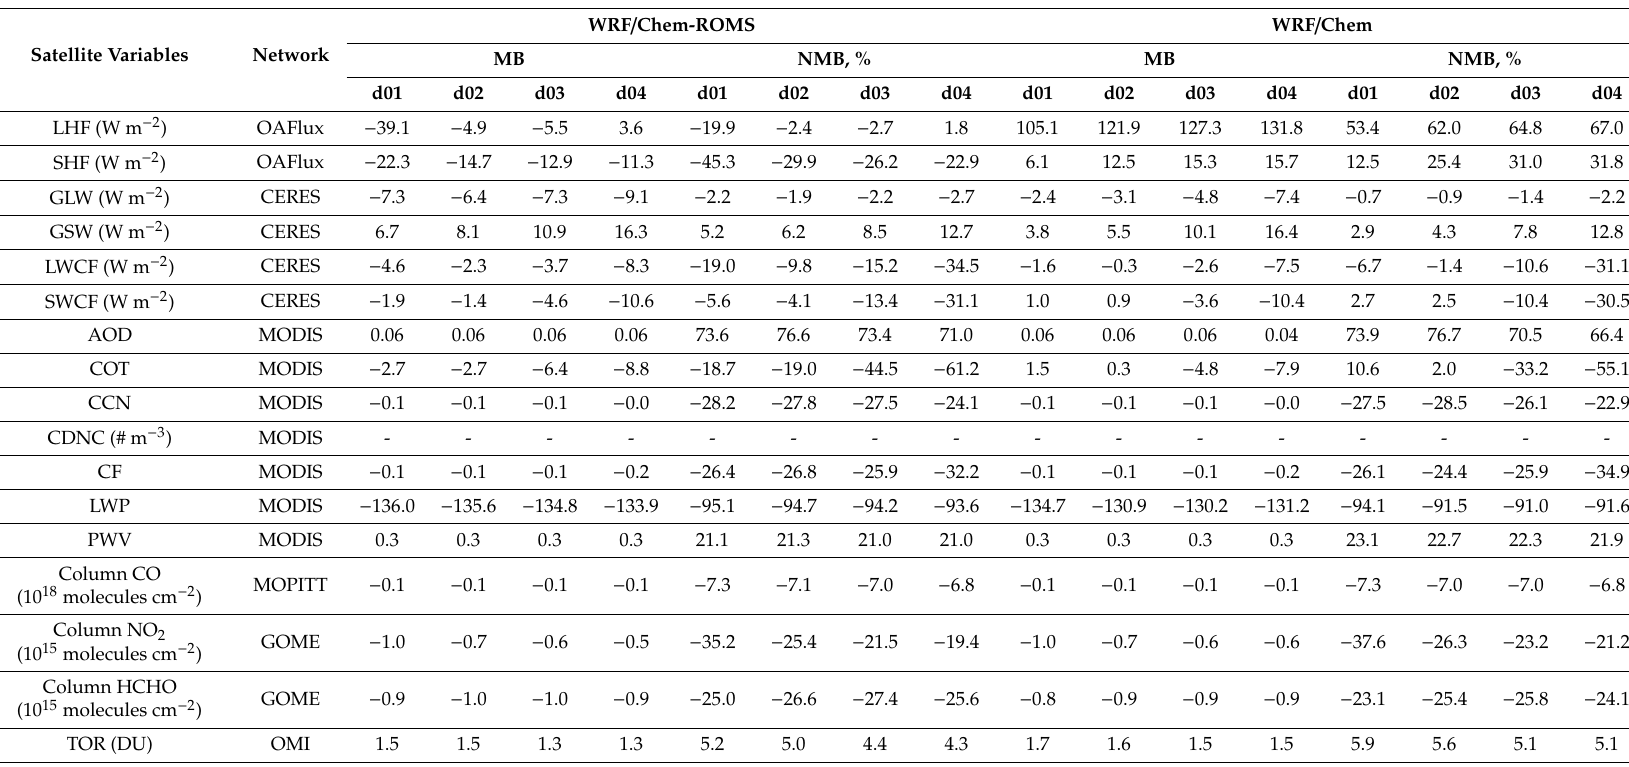
Table 5. Mean bias (MB) and normalized mean bias (NMB) of column variables from WRF / Chem and WRF / Chem-ROMS simulations at 81 km (d01), 27 km (d02), 9 km (d03), and 3 km (d04) over the 3 km domain for the SPS2 field